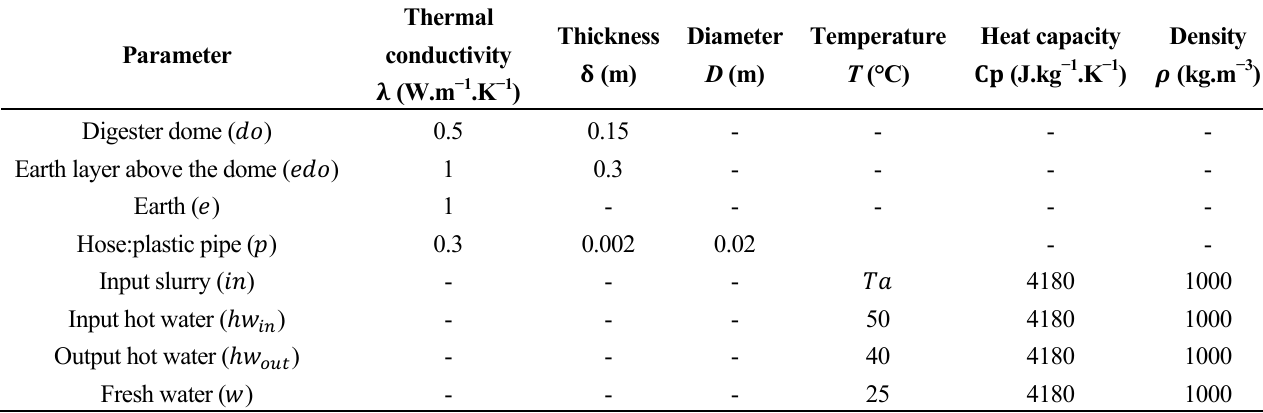
Table 2. Parameters used in the